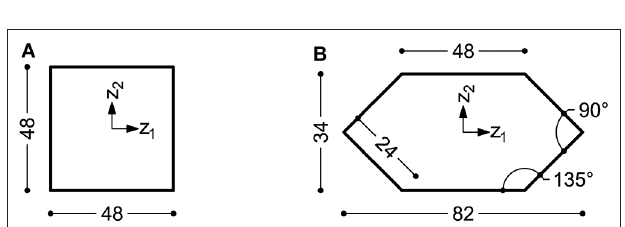
FIGURE 4 | Dimensions (in m) of the floors of two tall buildings: (A) a square plan building and (B) a hexagonal plan building (drawn in the macro-scale reference